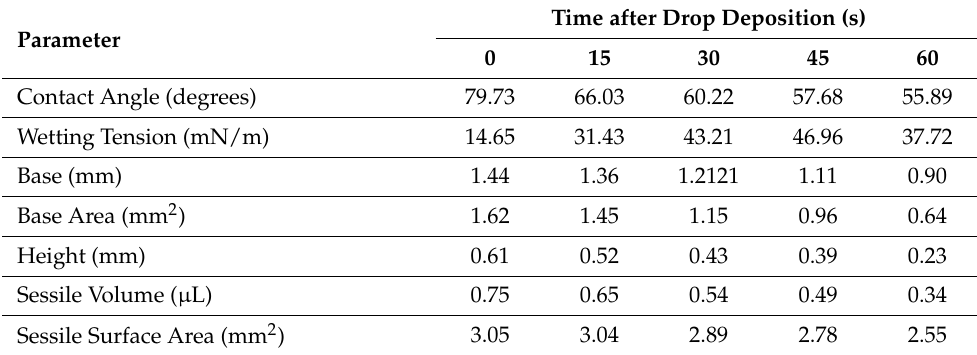
Table 3. Drop parameters as functions of time after deposition.